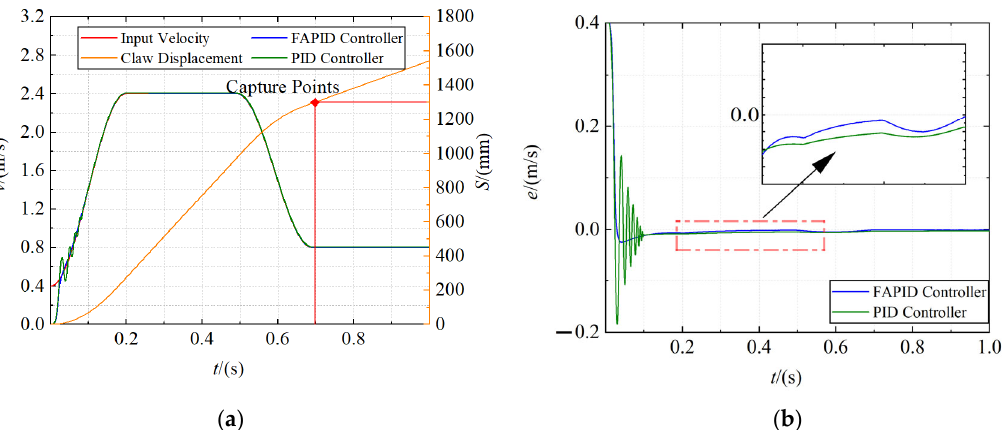
Figure 12. The capture curve of the mid range (1300 mm). ( a ) The velocity curve and displacement curve; ( b ) the error curve.